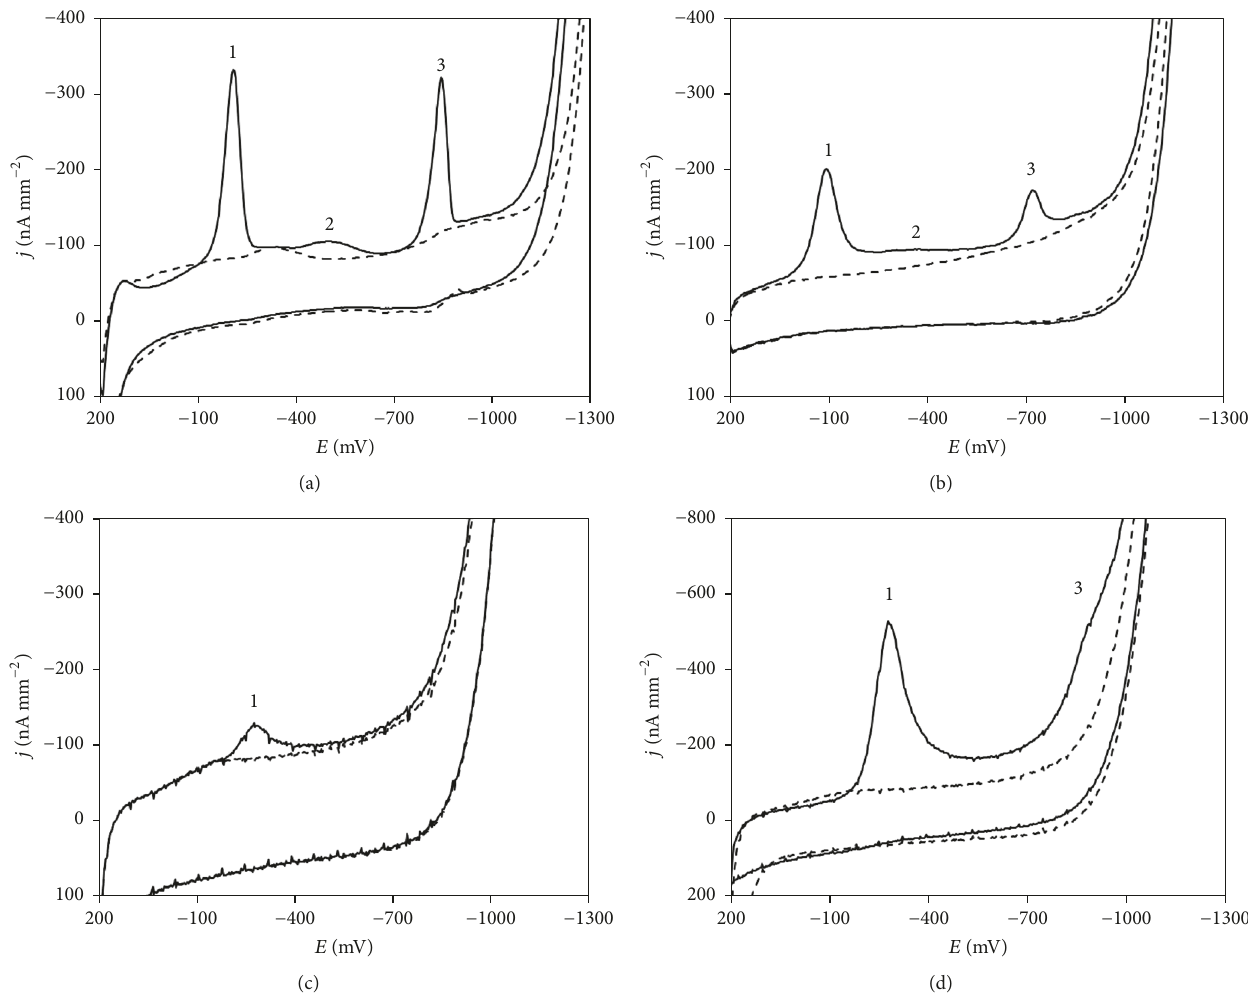
Figure 1: CV voltammograms of 5.0 × 10 −6 molL −1 DAN recorded on m-AgSAE (a), p-AgSAE (b), and BiFE (c). Electrolyte: BRB (pH 6.0); 𝐸 𝐸 − 1300mV; V = 100mVs −1 ; CV voltammogram of 5.0 × 10 −5 molL −1 DAN recorded on BiFE (d); dashed lines: supporting in = +200mV; fin = electrolyte; solid lines: after the addition of